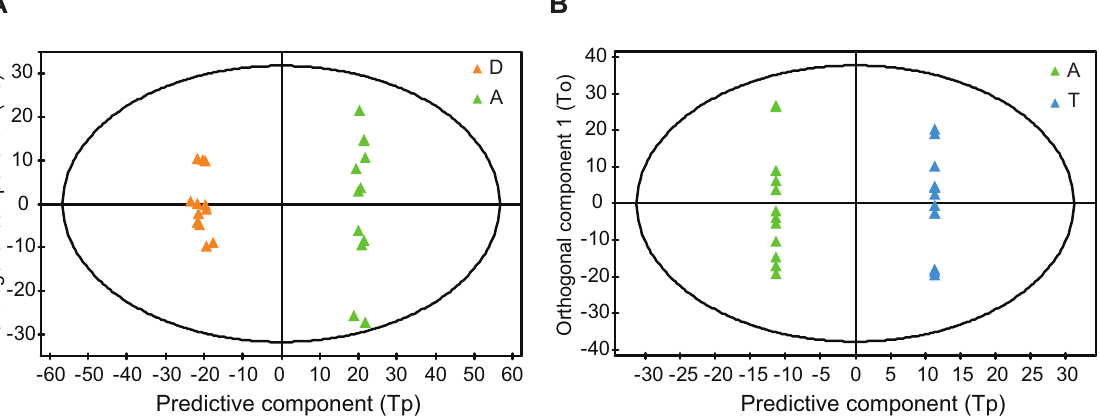
Figure 2. OPLS-DA modeling of diluent- (D), allergen- (A) or allergen + GC treated (T) CD4 + T cells from patients with seasonal allergic rhinitis in the training set. A ) OPLS of D and A (Model DvsA); B ) OPLS of A and T (Model